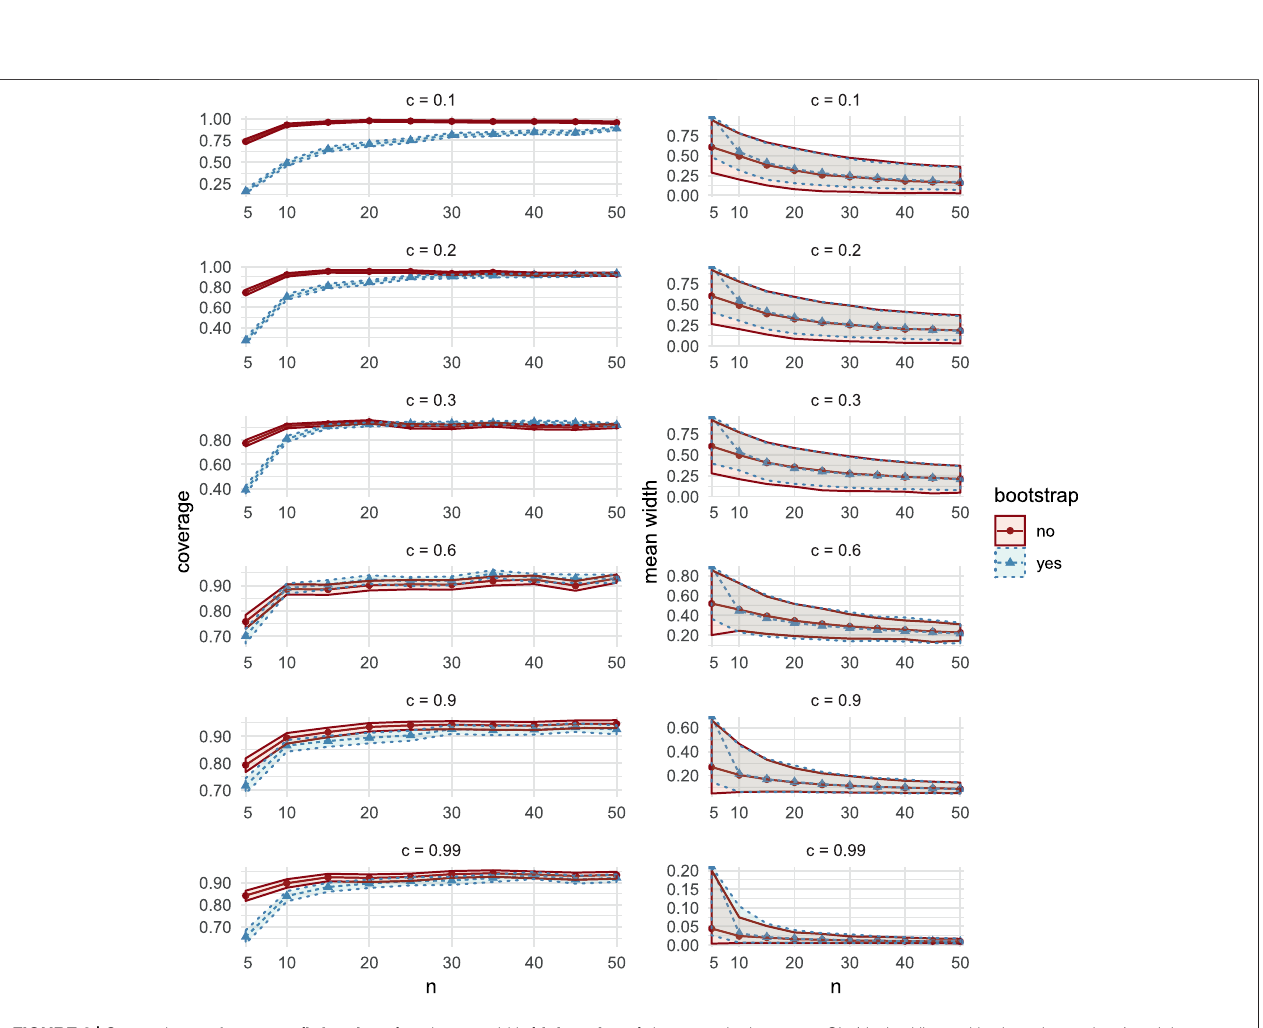
Frontiers in Applied Mathematics and Statistics |